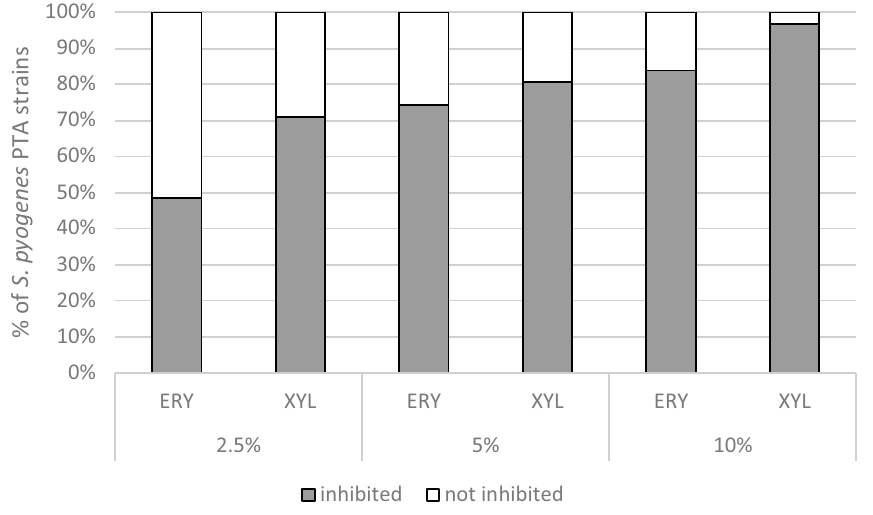
Figure 1. Effect of different concentrations (2.5%, 5% and 10%) of erythritol ERY and xylitol XYL on the growth of S. pyogenes PTA isolates (n = 31).